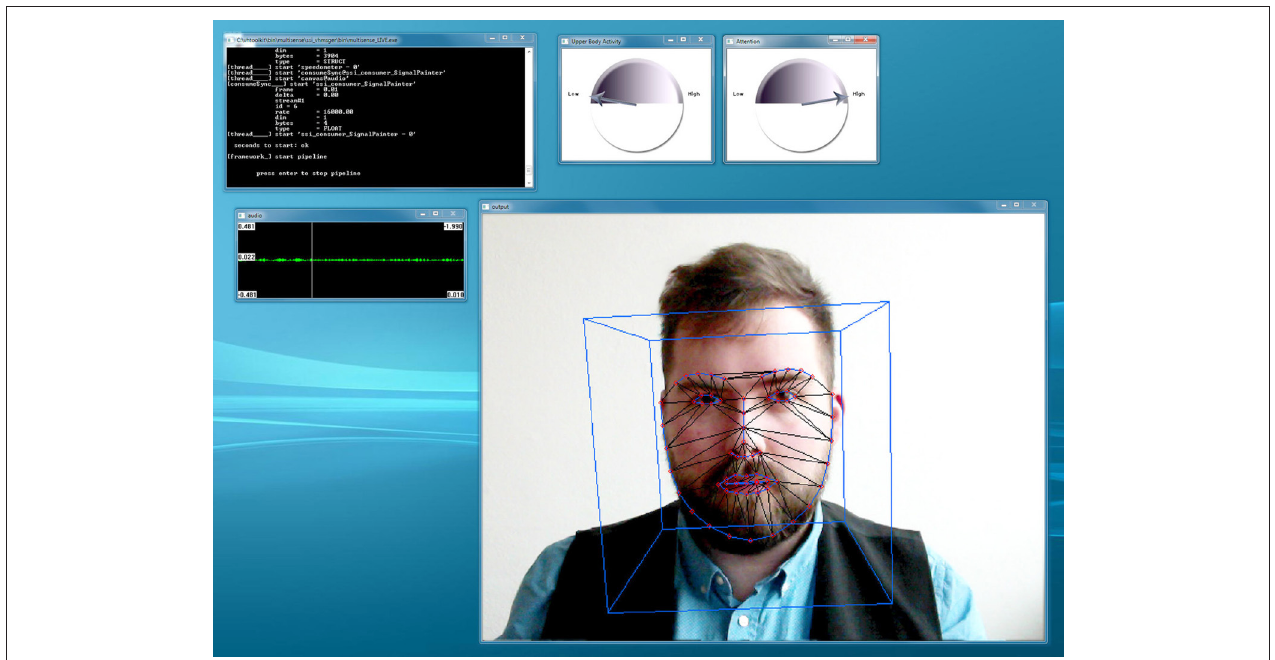
FIGURE 2 | MultiSense visualization used for the deceptive narrative of emotion recognition. The main window (bottom right) shows a live feed of the user’s face, with a 3D grid automatically fitted to relevant facial points (demonstrated by a study conductor in this image).